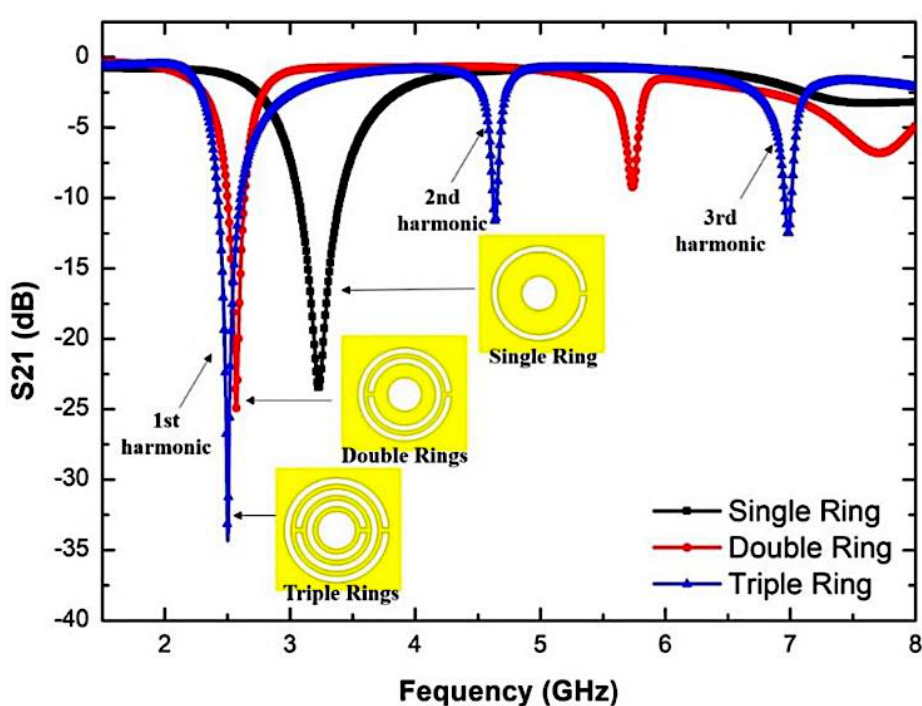
Figure 5. Simulated return loss characteristics of a single, double, and triple ring curve-feed CSRR sensor.